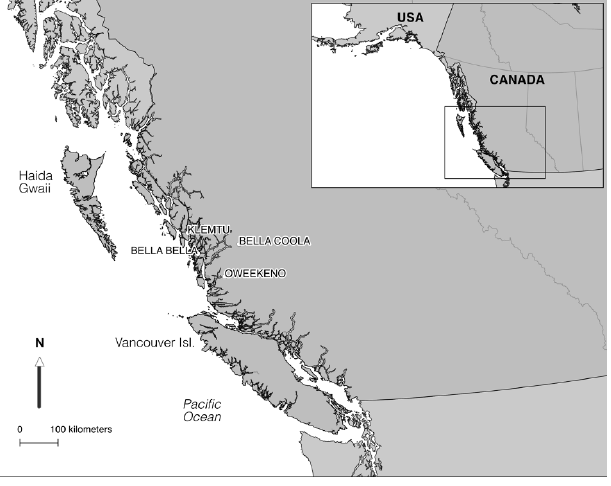
Fig. 1 . The study region encompassing the four First